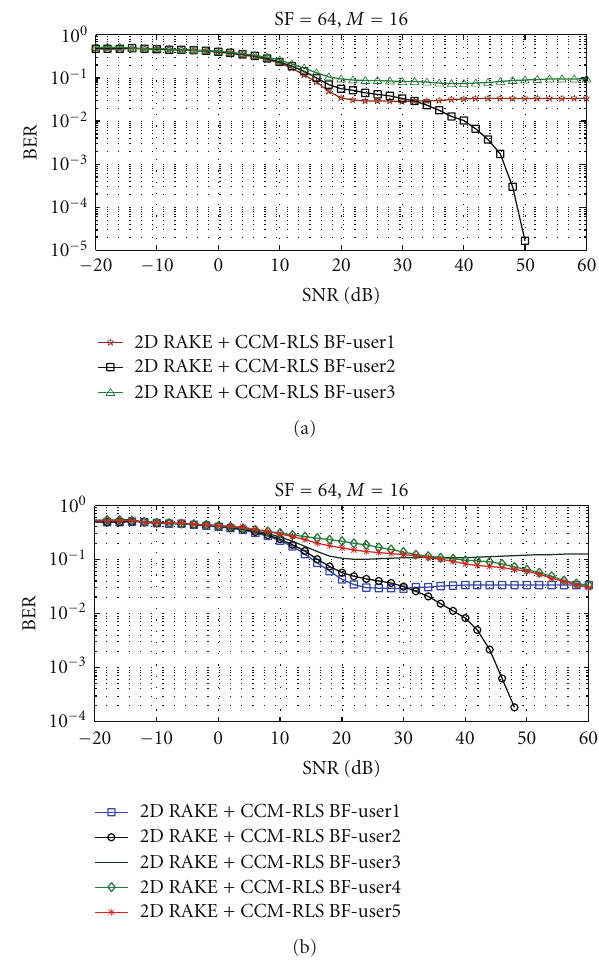
Figure 9: Performance of proposed receiver considering 16- element antenna array in 3-path AWGN fading channel for (a) 3 users, (b) 5